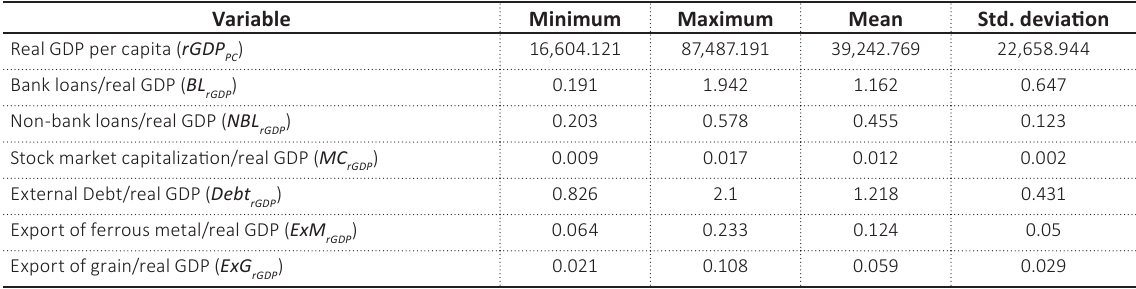
Table 2. Descriptive